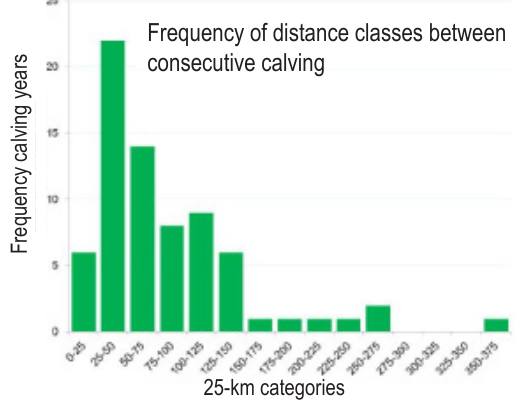
Fig. 5. Frequency classes based on distances between consecutive annual calving locations of satellite-collared breeding females, Ahiak herd,